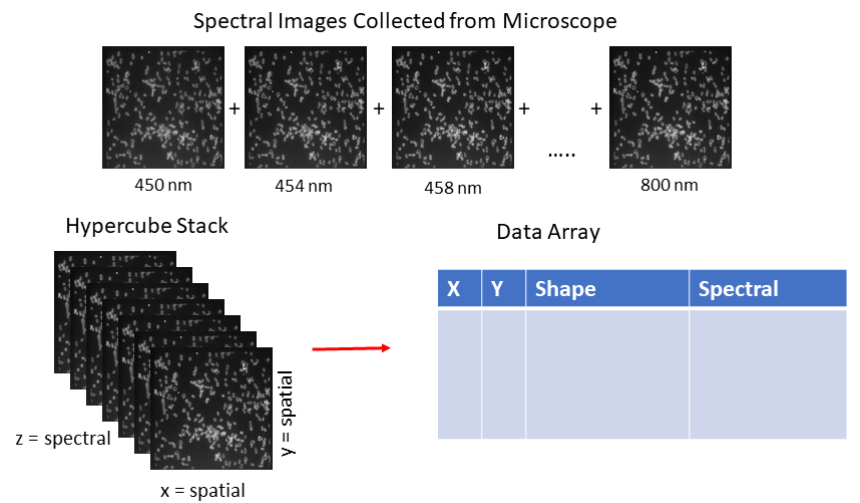
Figure 2. Representation of data collection of hyperspectral microscope images of bacterial cells between 450 and 800 nm.